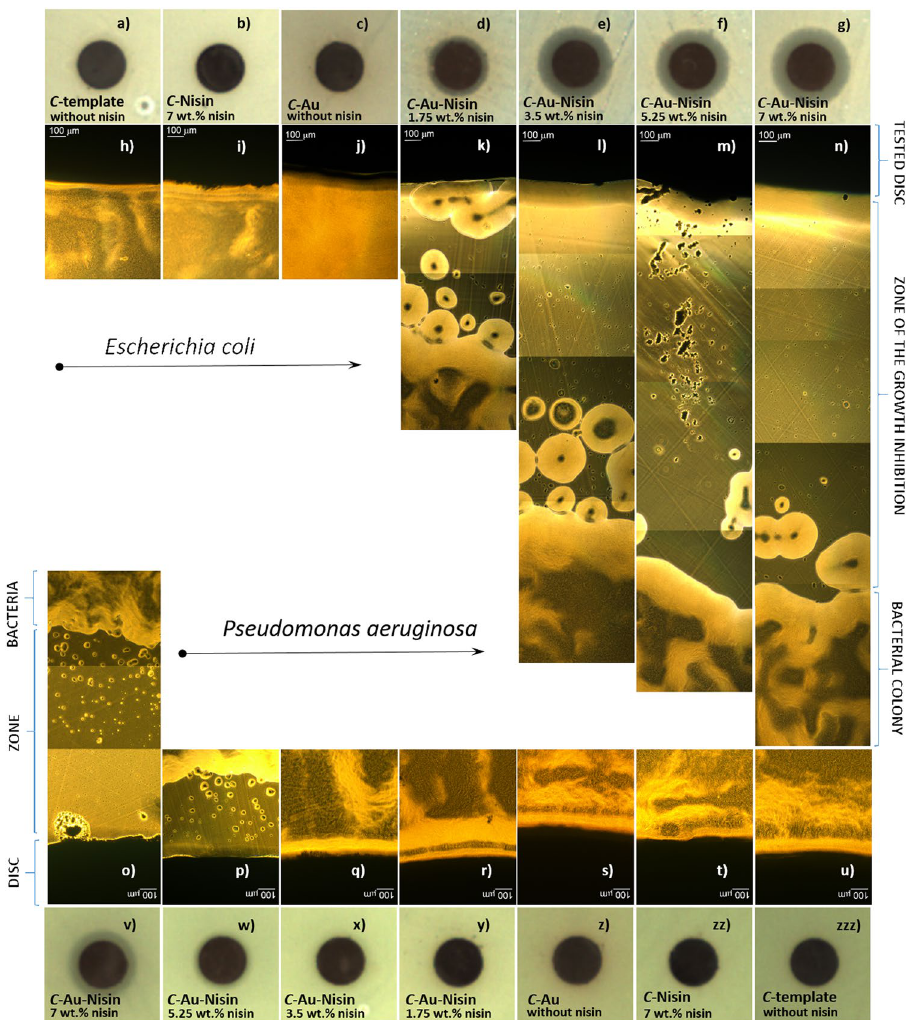
Figure 5. Susceptibility to Gram negative bacteria. Disc diffusion tests for the growth of: Escherichia coli around the pellets containing C -templates ( a ), C -templates/ nisin (containing 7 wt.% of pure nisin) ( b ), C -templates with Au nano-features (without nisin) ( c ) and C -templates with Au nano-features functionalized with nisin (containing 1.75, 3.5, 5.25 and 7 wt.% of pure nisin) ( e – g ) as well as Pseudomonas aeruginosa around the pellets containing C -templates ( zzz ), C -templates with nisin (8 mg/ml) ( zz ), C -templates with Au nano-features (without nisin) ( z ) and C -templates with Au nano-features functionalized with nisin (containing 1.75, 3.5, 5.25 and 7 wt.% of pure nisin) ( x–v